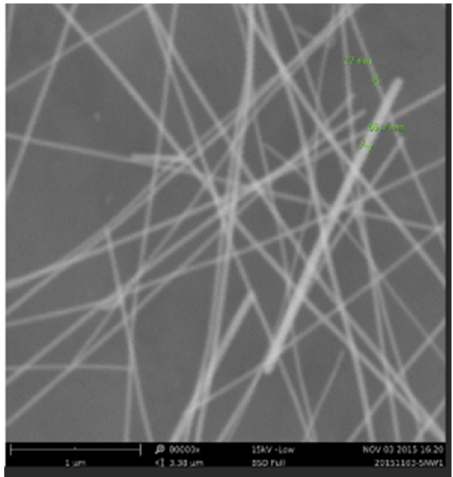
Figure 1: SEM image of the conductive network formed by of CF in PVA matrix [ 29 ]